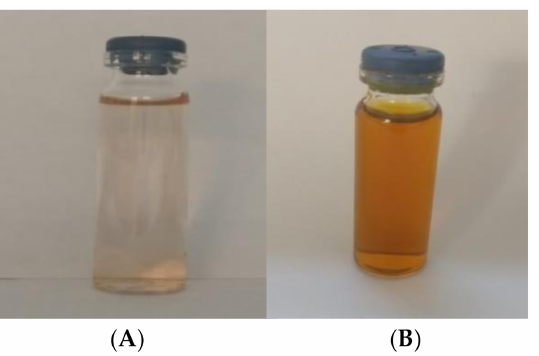
Figure 1. Color of the solution pecan nut shell extract before ( A ) and after ( B ) of reaction with AgNO 3 .